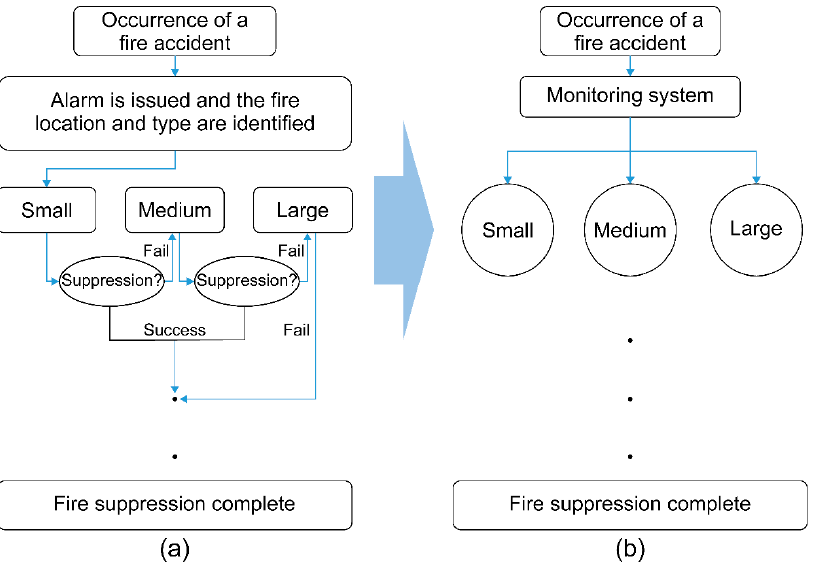
Figure 11. Proposed accident response process: ( a ) Before applying the algorithm; and ( b ) After applying the algorithm.